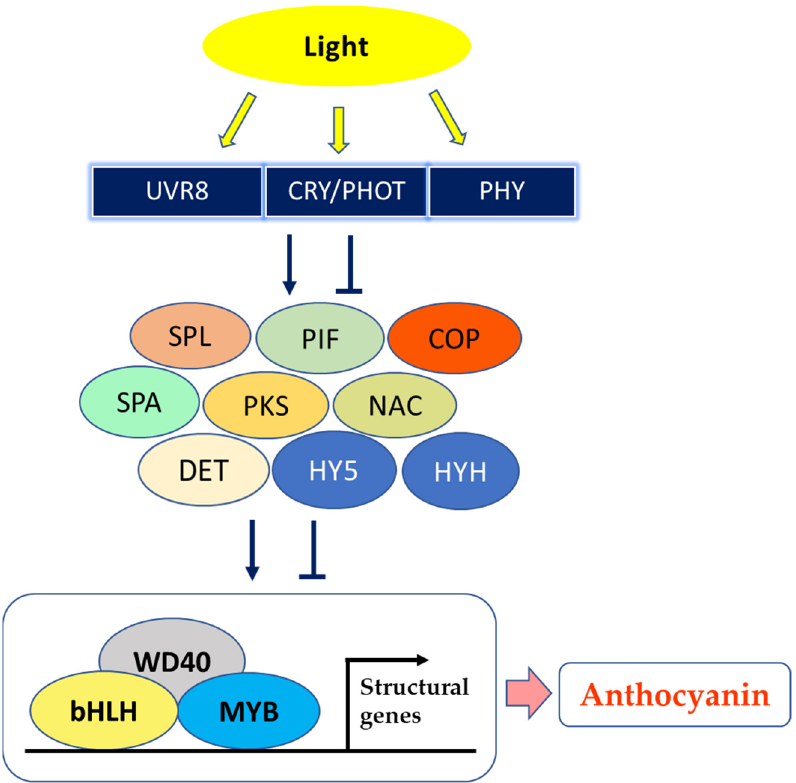
Figure 2. A model showing fruit peel coloration induced by light. UVR8—UV resistance locus 8; CRY—cryptochrome; PHOT—phototropin; PHY—phytochrome; SPL—SQUAMOSA promoter- binding protein-like; PIF—phytochrome-interacting basic helix–loop–helix transcription factors; COP—constitutive photomorphogenic; SPA—suppressor of PHYA; PKS—phytochrome kinase substrate; NAC—NAM (no apical meristem)/ATAF (Arabidopsis transcription activation factor)/CUC (cup-shaped cotyledon) transcription factor; DET—DE-ETIOLATED; HY5—elongated hypocotyl 5; HYH—HY5 homolog; WD40—WD40 domain-containing protein; bHLH—basic he- lix–loop–helix; MYB—myeloblastosis (modified after Chaves-Silva et al. [73], Zhao et al. [74], Ma et al. [81] and Zhou et al. [83]).